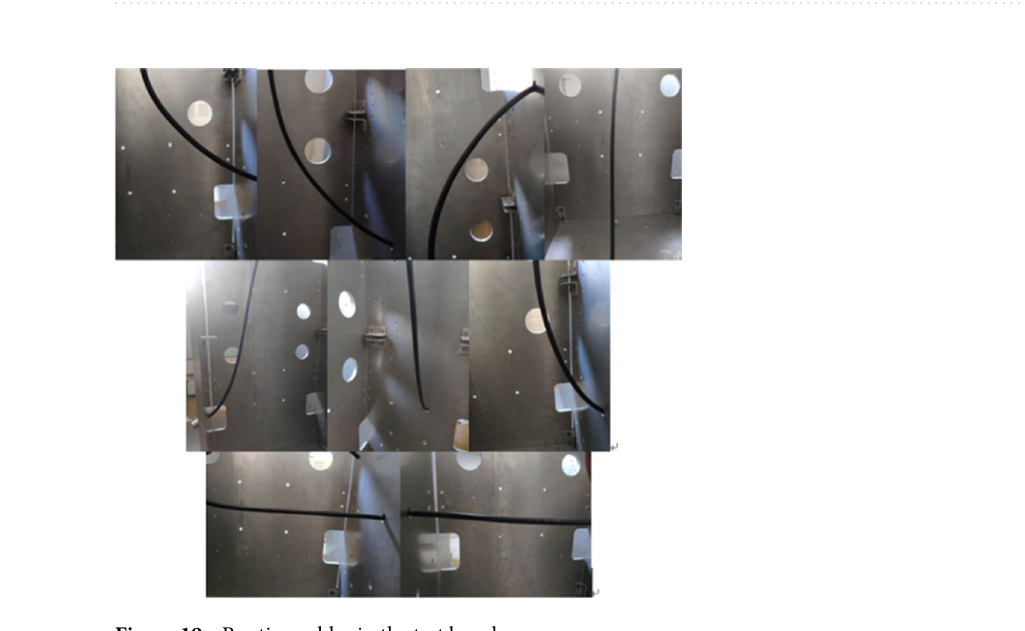
Figure 19. Routing cables in the test bench.